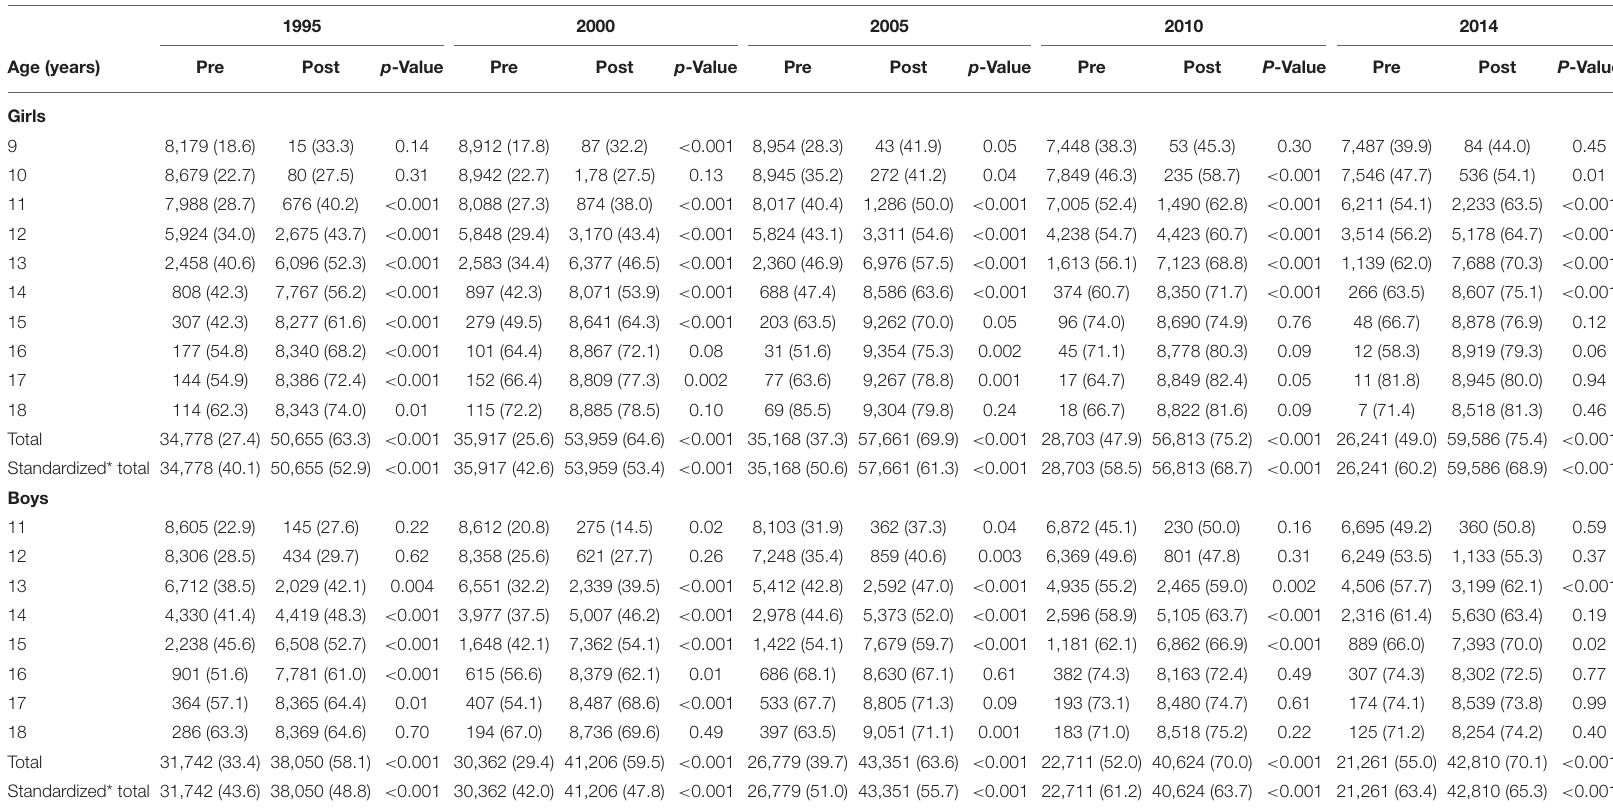
TABLE 1 | Comparison of myopia prevalence between pre- and post-menarche/spermarche subjects by sex and age, 1995–2014 [sample size (%)].